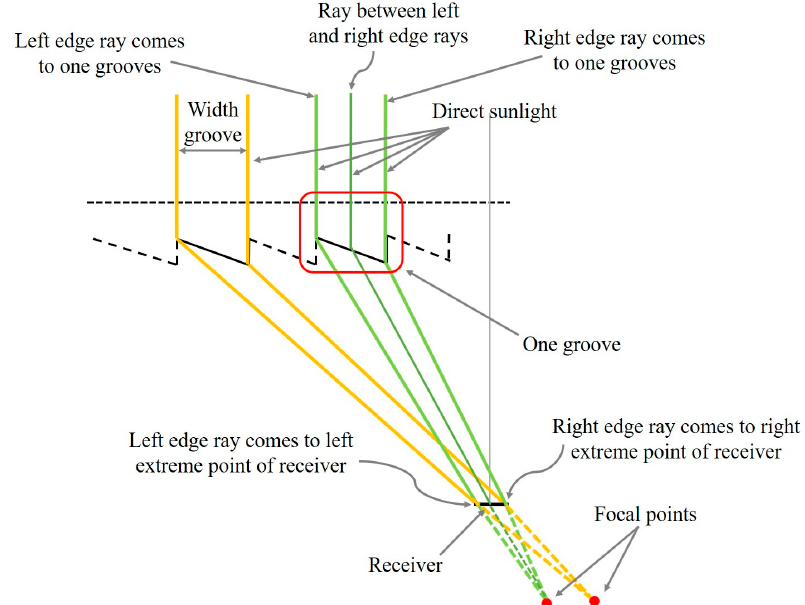
Figure 6. The edge ray principle is applied to design one groove, in which the left edge ray, the right edge ray, and an example of ray between left and right edge rays coming to one groove are shown.